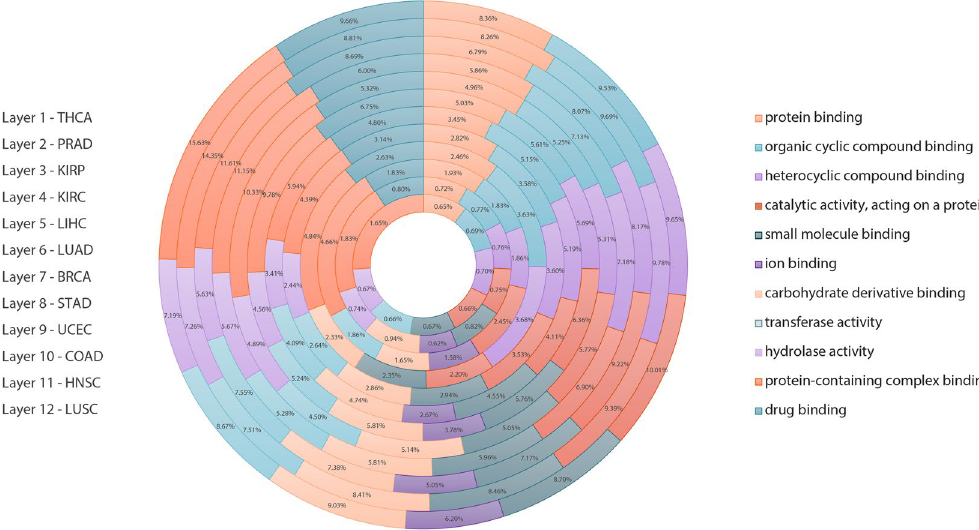
Figure 7. Over-representation analysis for different cancer types. The graph shows the percentages of DIPs in various molecular functions to all genes participating in these molecular functions for different cancer types. Each molecular function is represented in different color and name of the cancers are indicated on the left going from the inner to the outer layer.